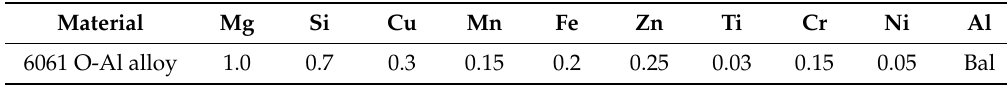
Table 1. Chemical composition (wt.%) of the 6061-O Al alloy.